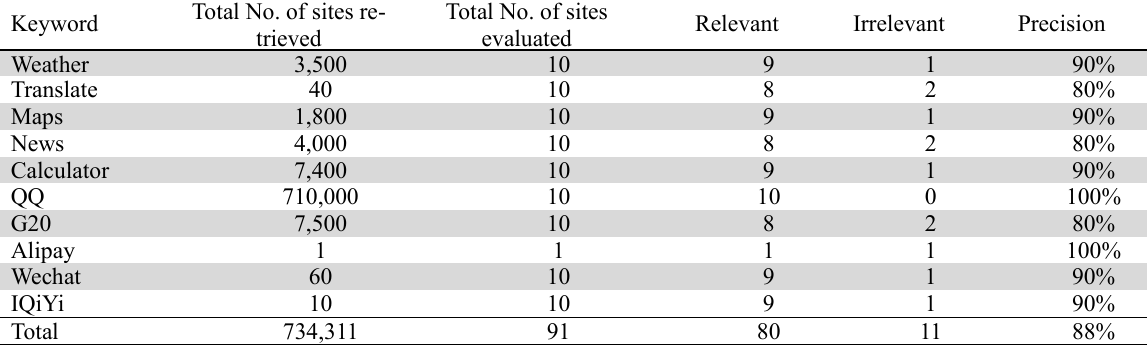
Precision of JD.COM SEs